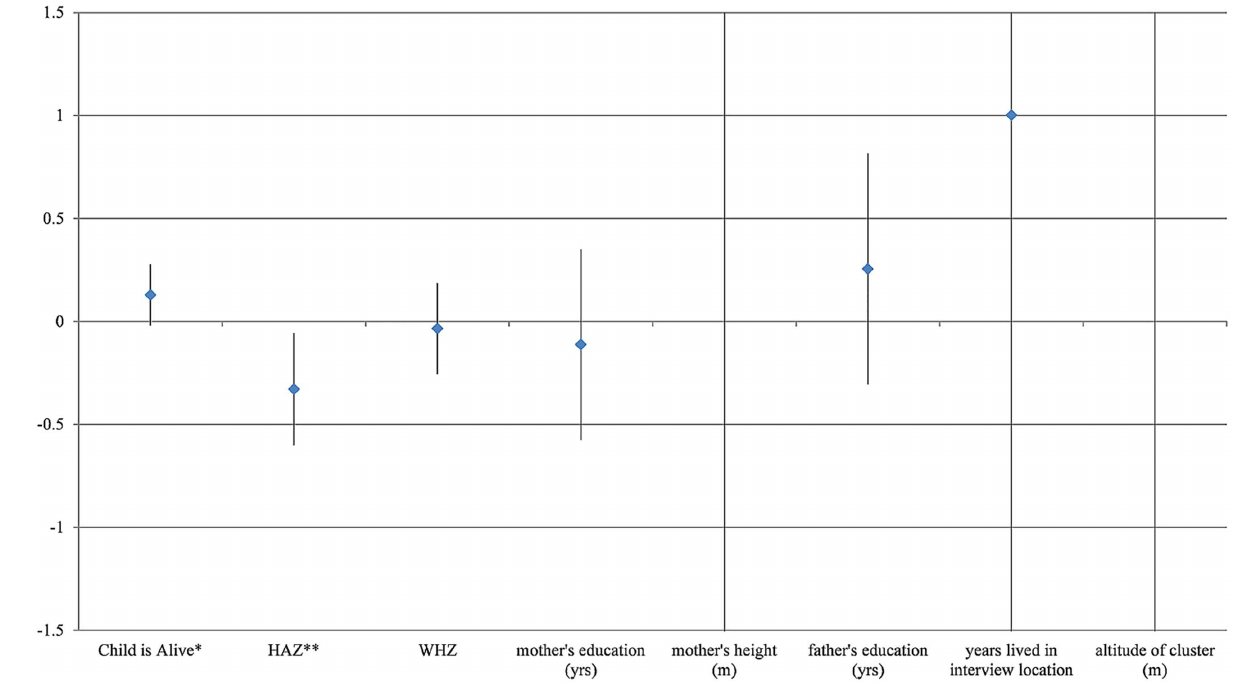
Fig 5. Falsification test results. Notes: In areas with seasons: estimated averagetreatment effects for various "placebo" dependent variablescomparedwith Mortality, HAZ, and WHZ estimates. * indicatesthe ATE is significantat 10%, and ** 5%. Data shown are coefficient estimates (in blue) and 95% confidenceintervals for “averagetreatment effects” in our preferredspecification(Table 6), for our three dependentvariablesof interest followedby five ‘placebo’ variables for which no effect is expectedof our ‘treatment’, due to the absenceof any plausible mechanismof